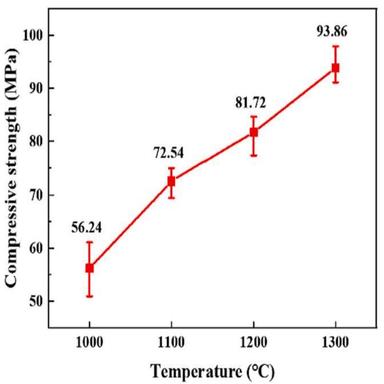
Compressive strength of samples with different sintering temperatures.